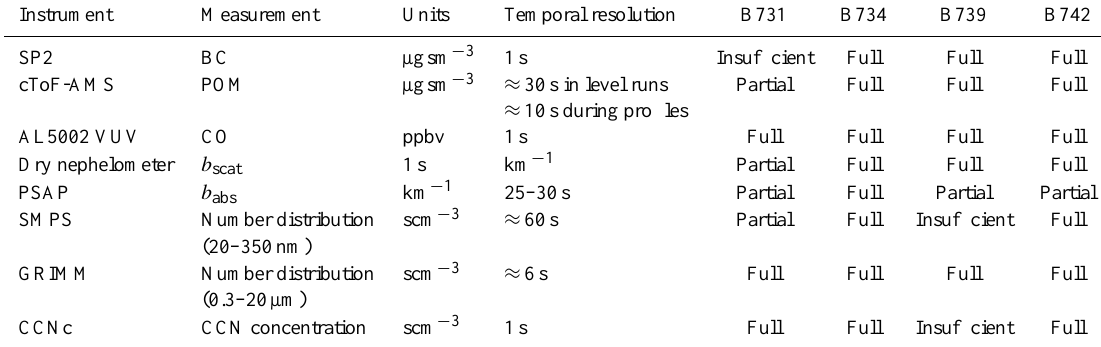
Table 4. Table of instrumentation used during SAMBBA flights B731 (14 September 2012), B734 (18 September 2012), B739 (23 Septem- ber 2012) and B742 (27 September 2012). The coverage of each instrument for each flight is indicated by the categories: Full ( > 80 % coverage); Partial (between 80 and 30 %); or Insufficient ( < 30 %). For details of instruments see text in Sect. 4.2. Mass and number mixing ratios given per unit volume at standard temperature and pressure (sm − 3 or scm − 3